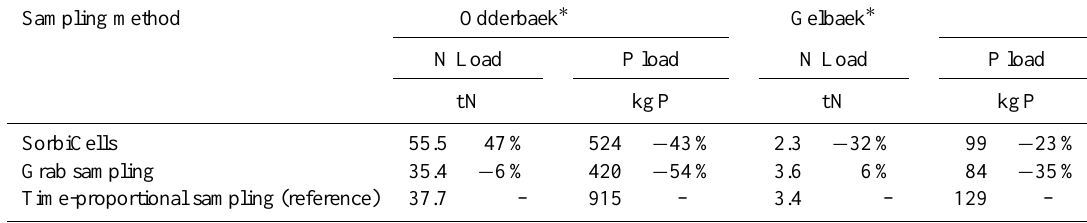
Table 3. Nitrate and phosphorus loads for three sampling methods in two streams. Deviation from the reference is given as as a percentage. Sampling method